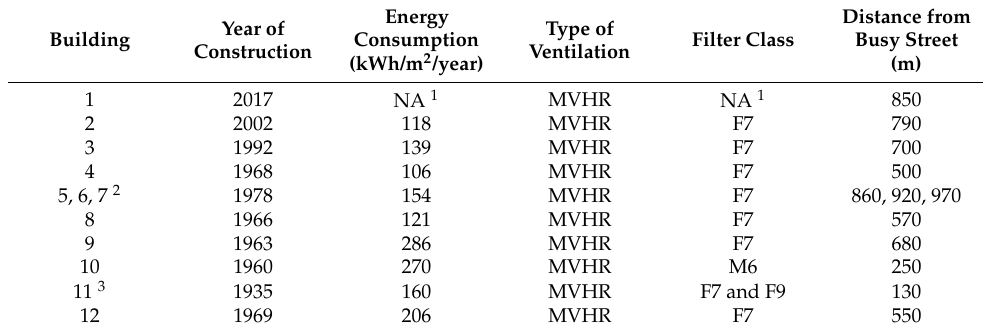
Table 1. Technical characteristics of the buildings. Mechanical ventilation with heat recovery (MVHR) is used in all buildings.